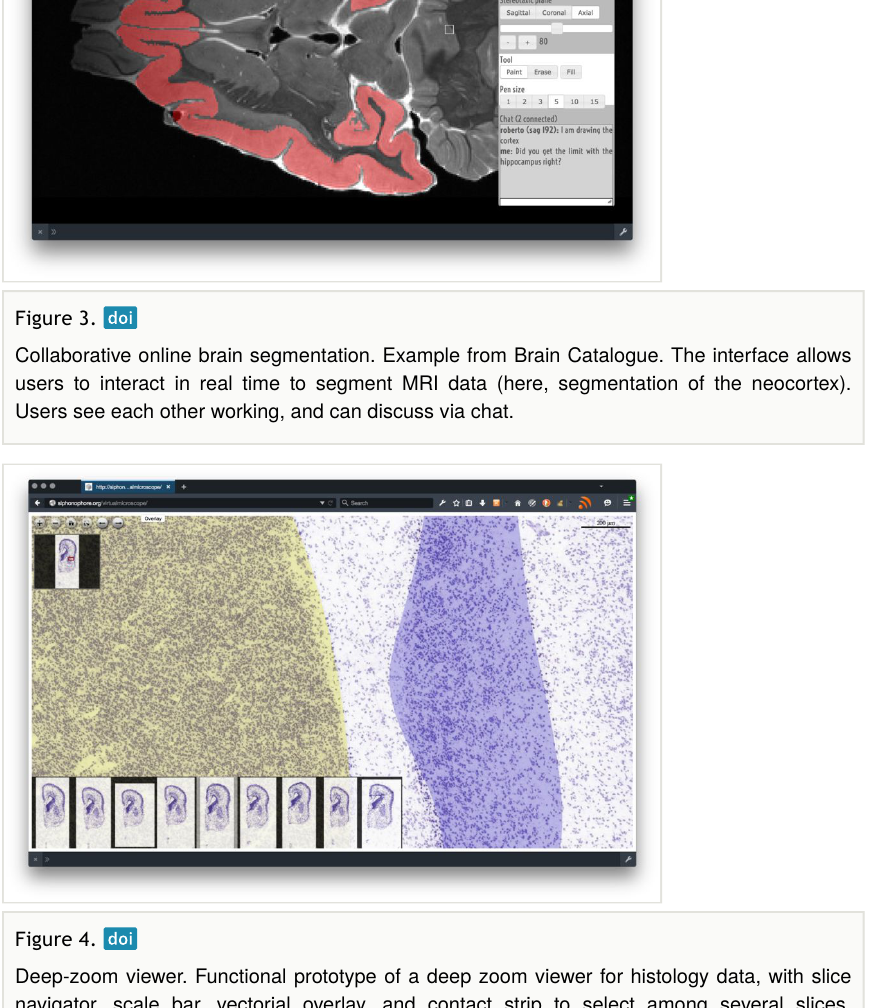
Deep-zoom viewer. Functional prototype of a deep zoom viewer for histology data, with slice navigator, scale bar, vectorial overlay, and contact strip to select among several slices. Histology data obtained from the Allen Institute for Brain